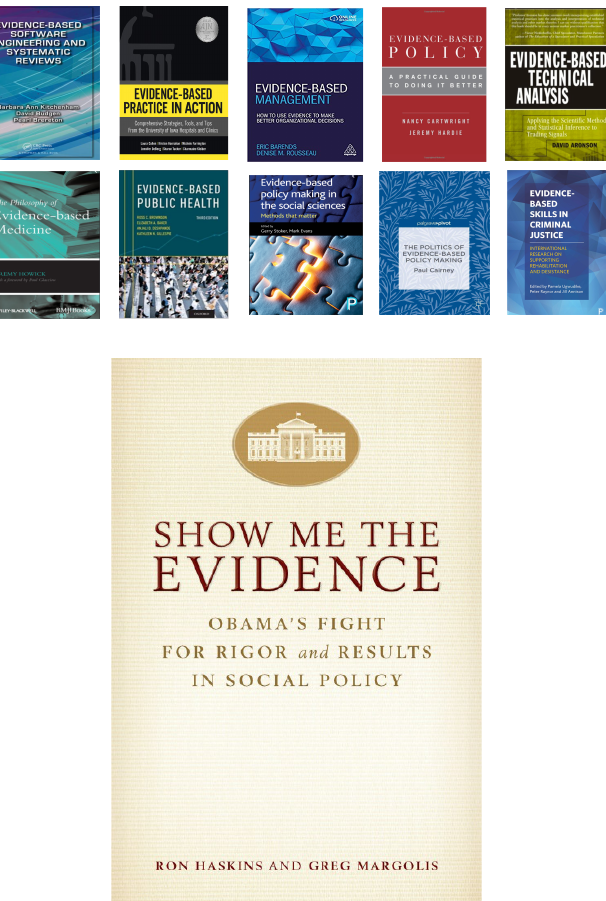
Figure 3. Books written on